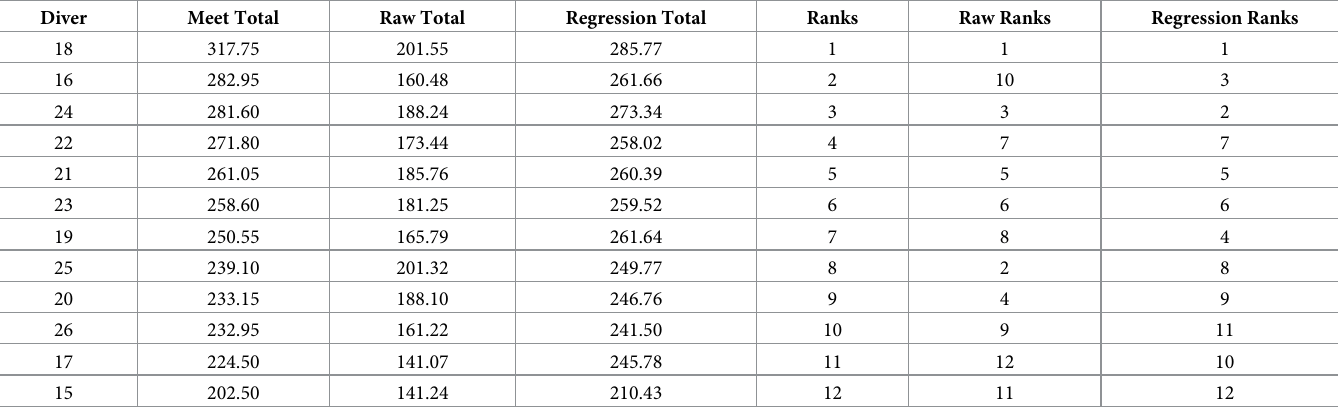
Table 5. Actual scores and rankings of all male divers compared with rankings from using the raw measurements and the regression model.